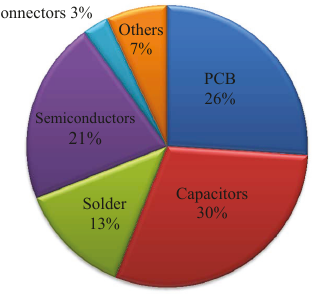
Fig. 1. Ranking and failure distrbution of power electronic components in power converters